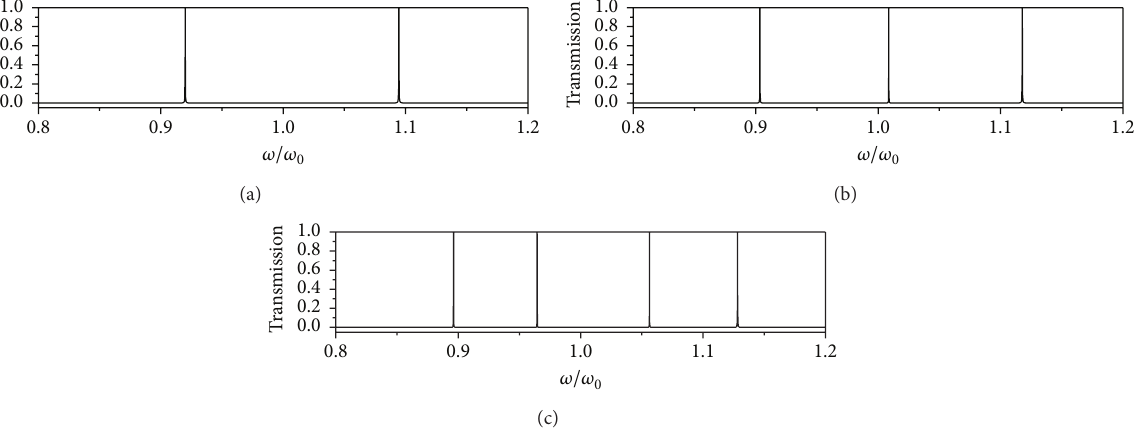
Figure 5: The quantum transmissivity for QW structure (𝐵𝐴) 6 (𝐵𝐵𝐴𝐵𝐵) 𝑛 (𝐴𝐵) 6 with 𝑛 𝑏 = 2 . 45. (a) 𝑛 = 1, (b) 𝑛 = 2, and (c) 𝑛 = 3.